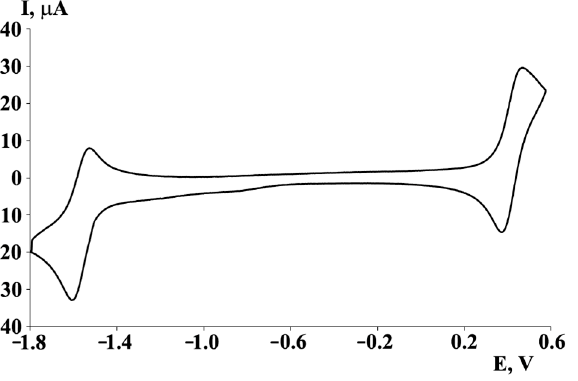
Figure 9. Cyclic voltammogram of 8 the potential switch from 0.55 to − 1.80 V (CH 2 Cl 2 , C = 2 mmol, 0.1 M TBAP, scan rate 200 mV ∙ s − 1 ). 0.1 M TBAP, scan rate 200 mV · s − 1 ).